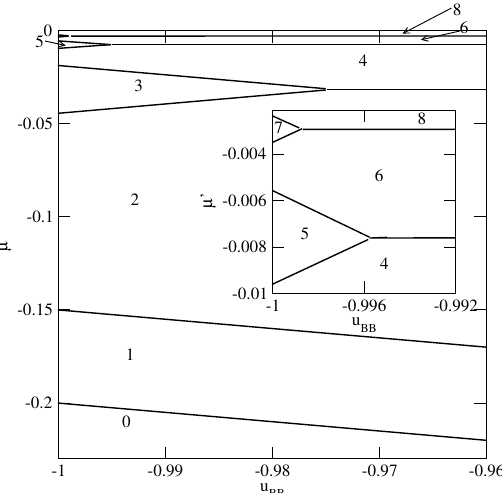
Figure 5. The ground state phase diagrams for the systems with V o = − 1.2. The inset shows the behavior for u BB close to − 1.0.